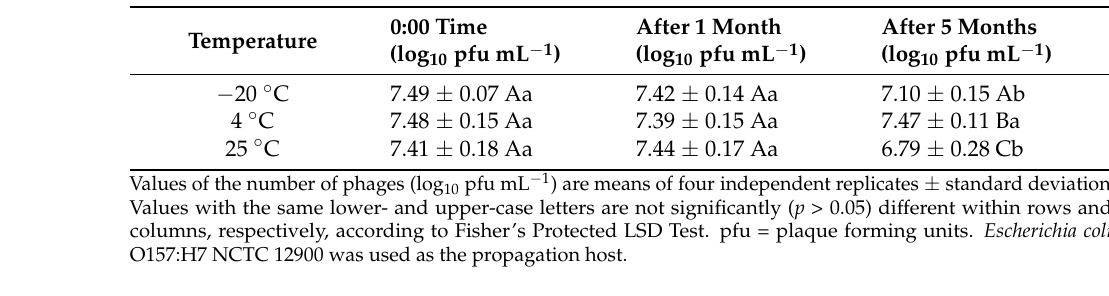
Table 4. Determination of optimum long term storage conditions of the phage